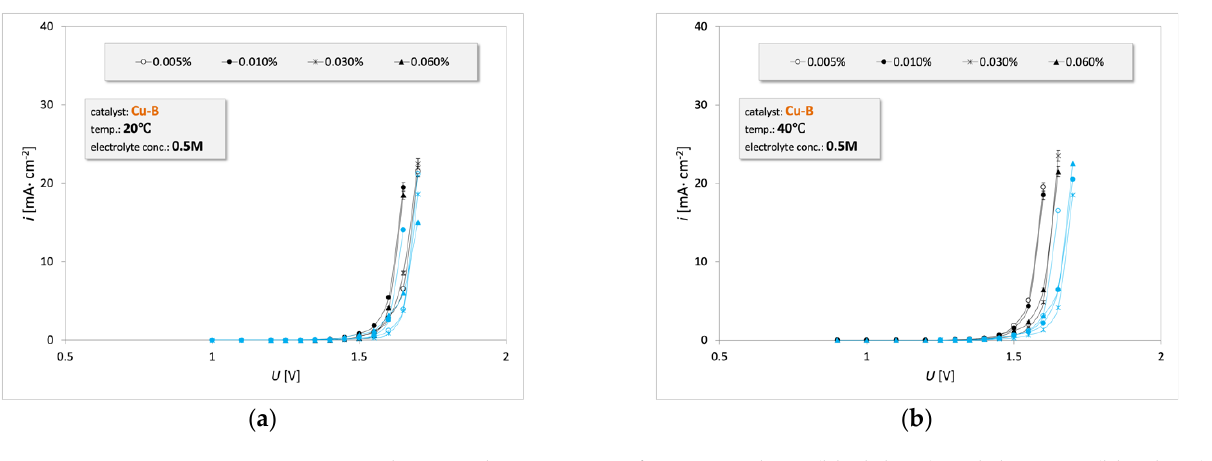
Figure 10. Electrooxidation curves of WEO emulsion (black lines) and detergent (blue lines) for various concentrations of detergent and emulsion on the Cu-B catalyst for an electrolyte concentration of 0.5 M. Electrooxidation: ( a ) temperature: 20 °C; ( b ) temperature: 40 °C.